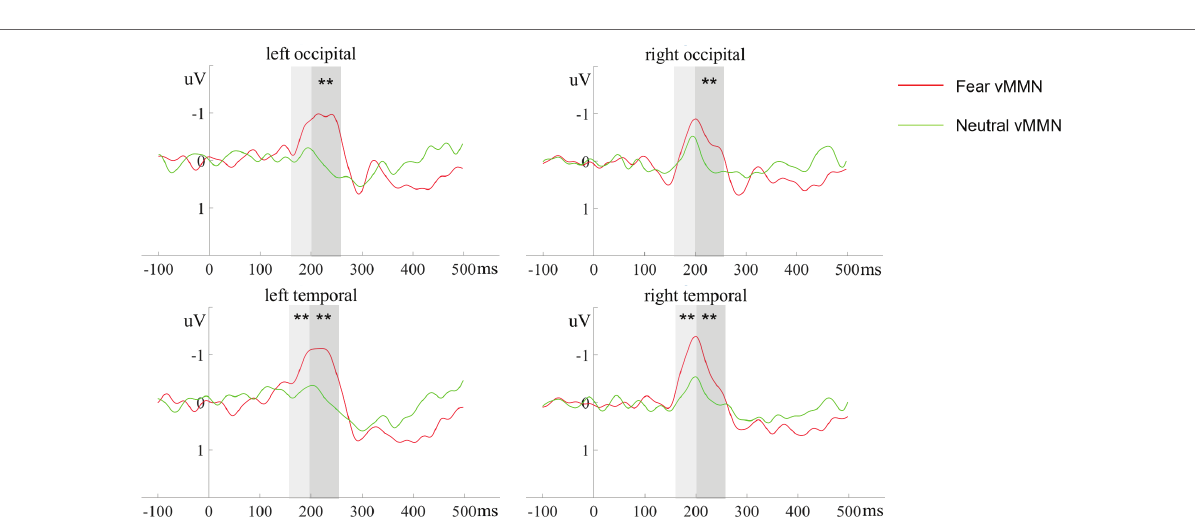
FIGURE 4 | The ERP responses to deviant-minus-standard differential (vMMN) waveforms at different electrode clusters evoked by devFear (red line) and devNeutral (green line). ** p < 0.01. The shaded area indicates the statistical analysis time windows of early and late vMMN, respectively.